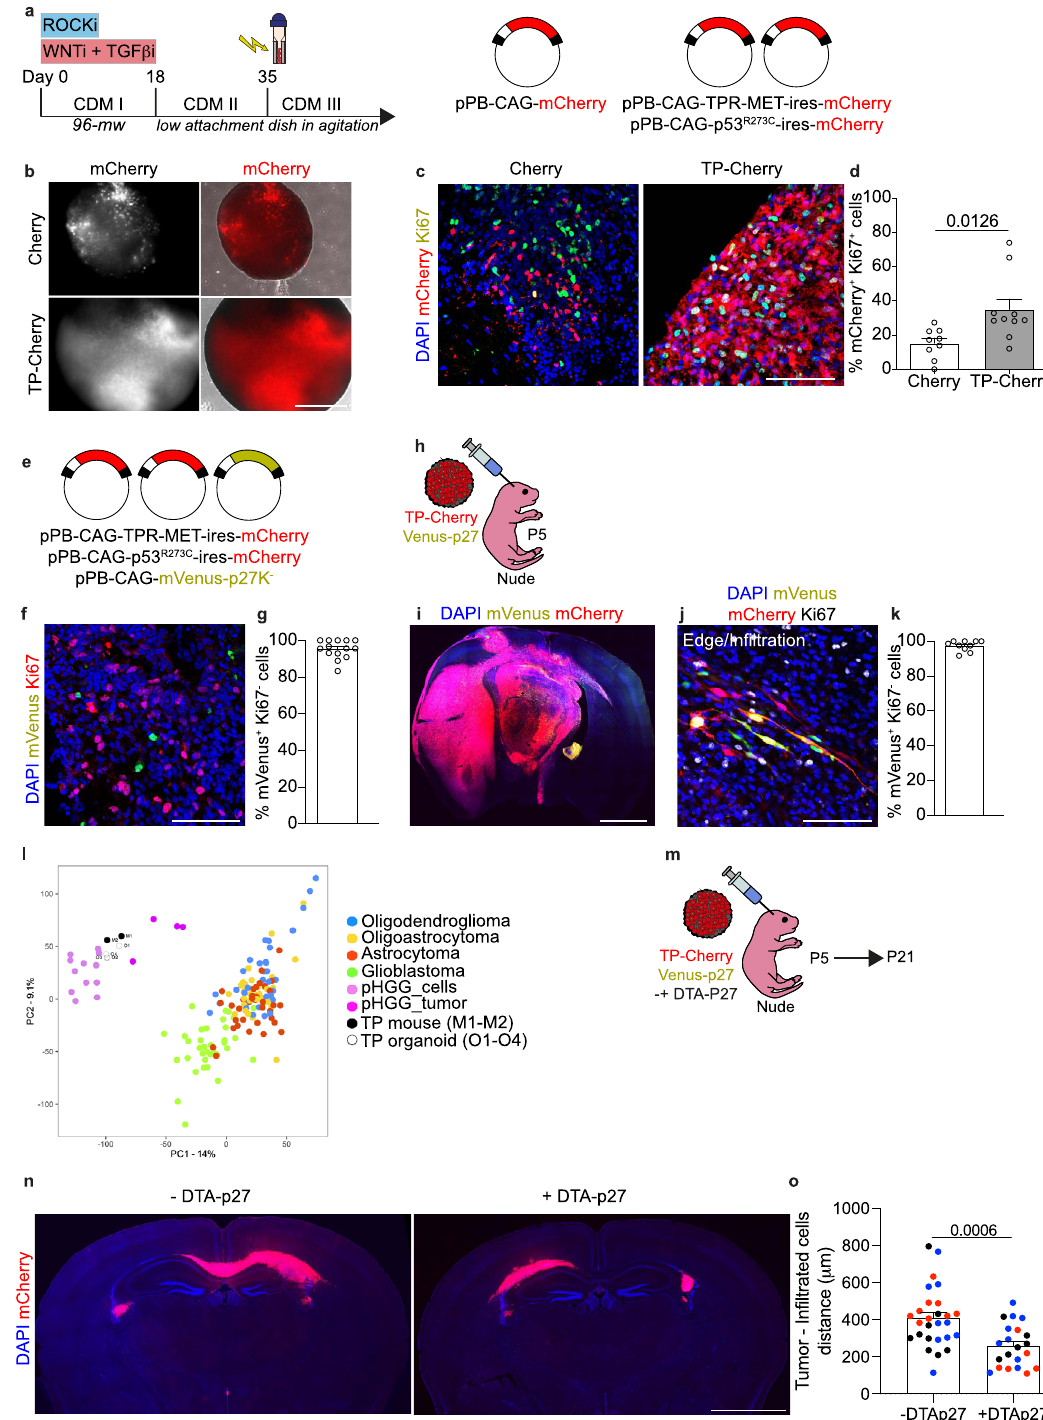
de fi ned in 15 . Cell-cycle thresholds were de fi ned fi rst by fi tting Gaussian distributions on empirical scores with the “ fi tdistrplus ” R package, and then selecting the 45 th and 40 th percentile of the fi tted distributions, respectively. Cells with both G1/S and G2/M expression scores below thresholds were considered as non- cycling. PROM1, SOX2 and OLIG2 positive and negative cells were de fi ned based on the presence or absence of scRNA-seq reads, respectively. Marker genes of cell populations were identi fi ed with the “ FindMarkers ” function of Seurat, setting as